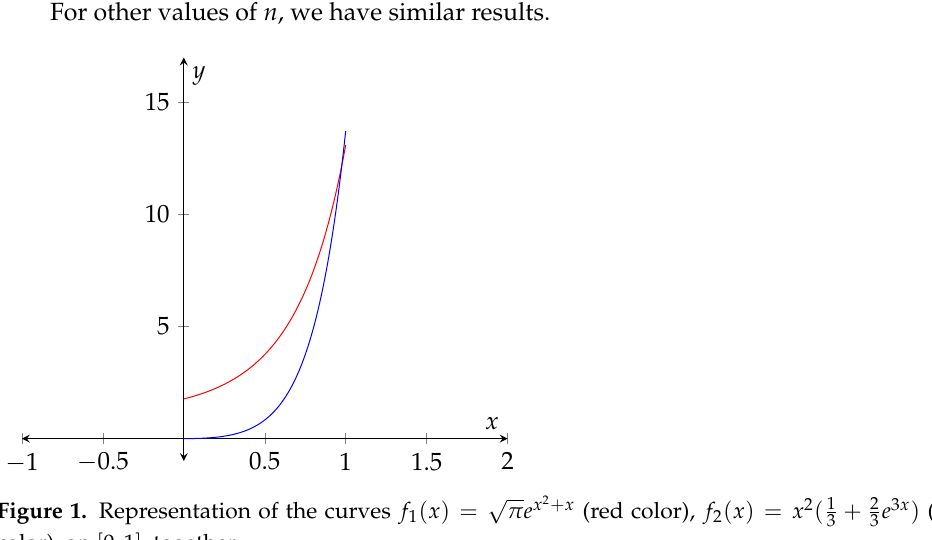
Figure 1. Representation of the curves f 1 ( x ) = color), on [ 0,1 ] ,